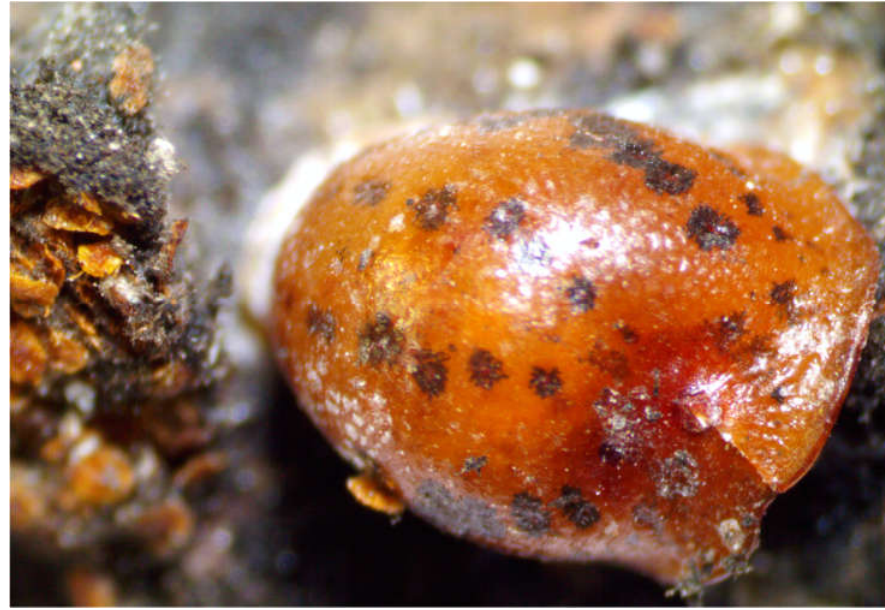
Figure 1. Toumeyella parvicornis adult female.